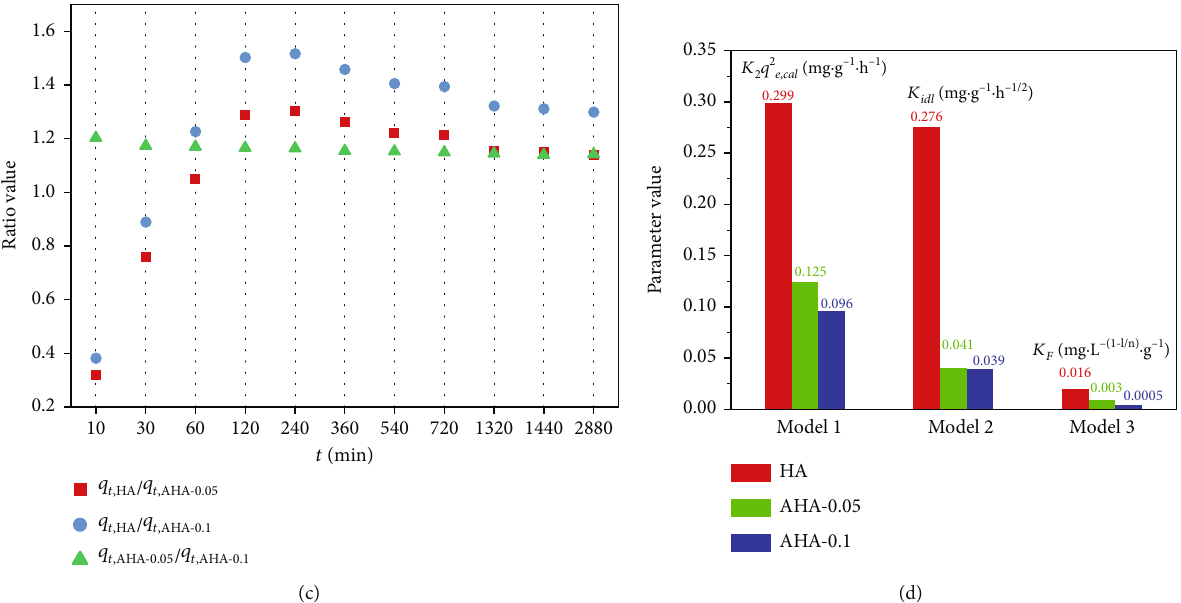
between two di ff erent adsorbents; (d) the t